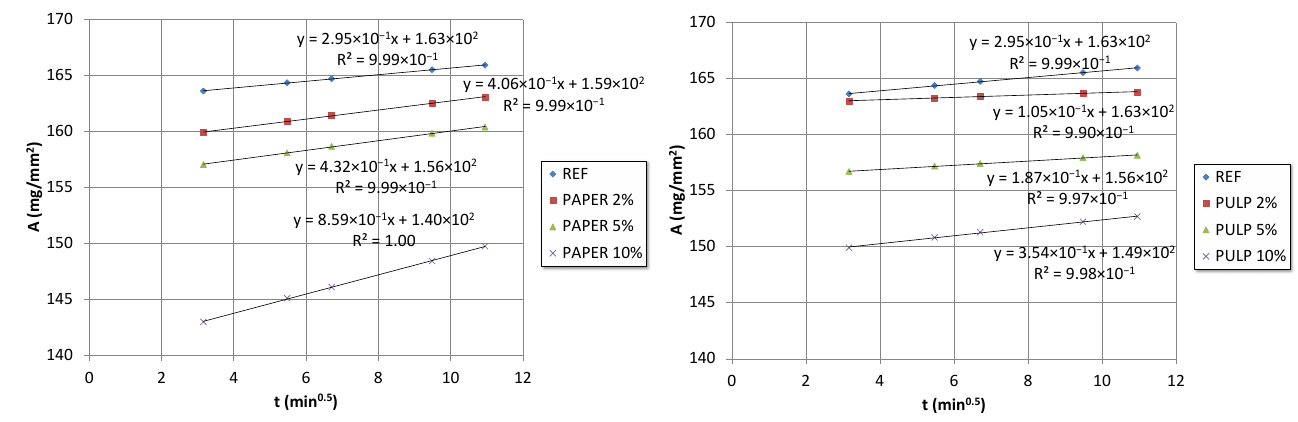
Figure 5. Capillary absorption vs. time square root: ( a ) ‘PAPER’ specimens, ( b ) ‘PULP’ specimens.